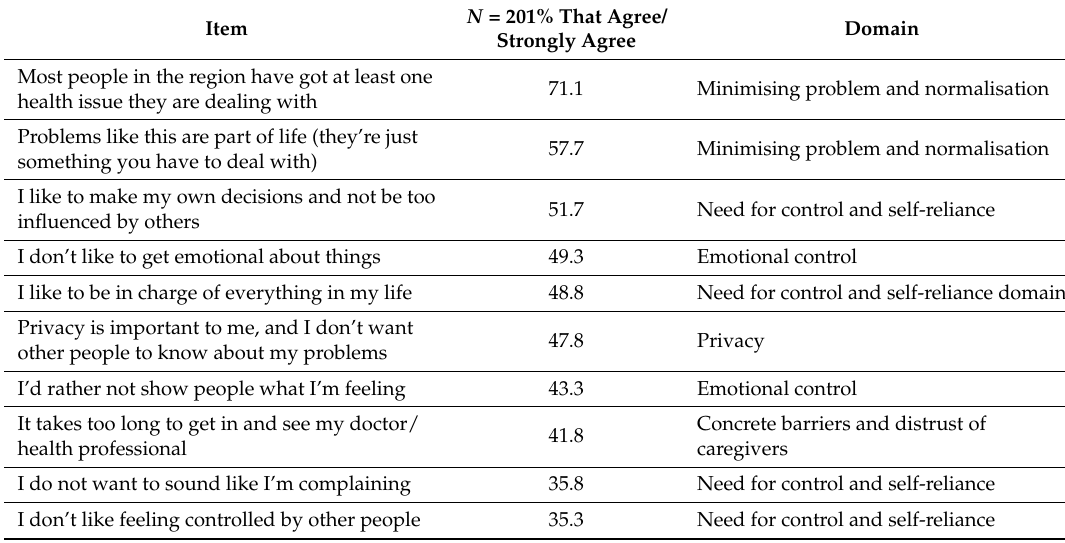
Table 4. Proportion (%) of sample that strongly agreed/agreed that the barrier was important and associated